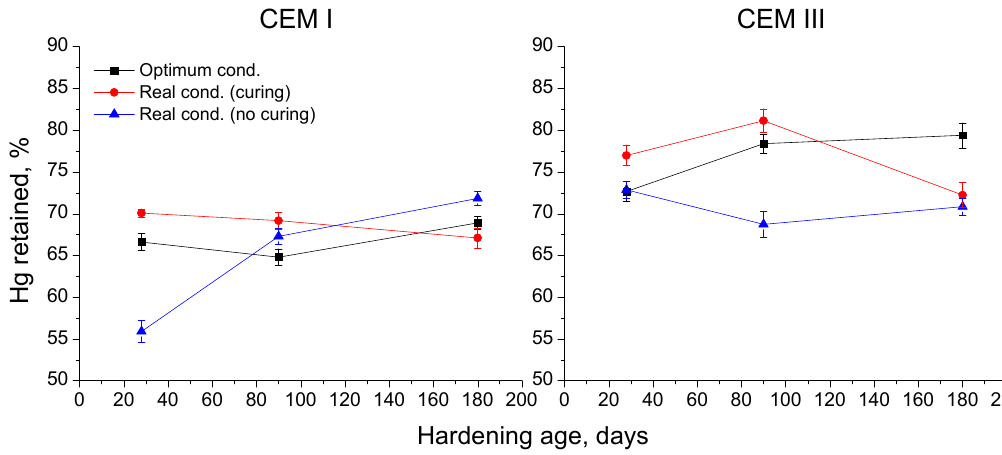
Figure 6. Results of mercury retained at the end of MIP tests for CEM I and III concrete samples.